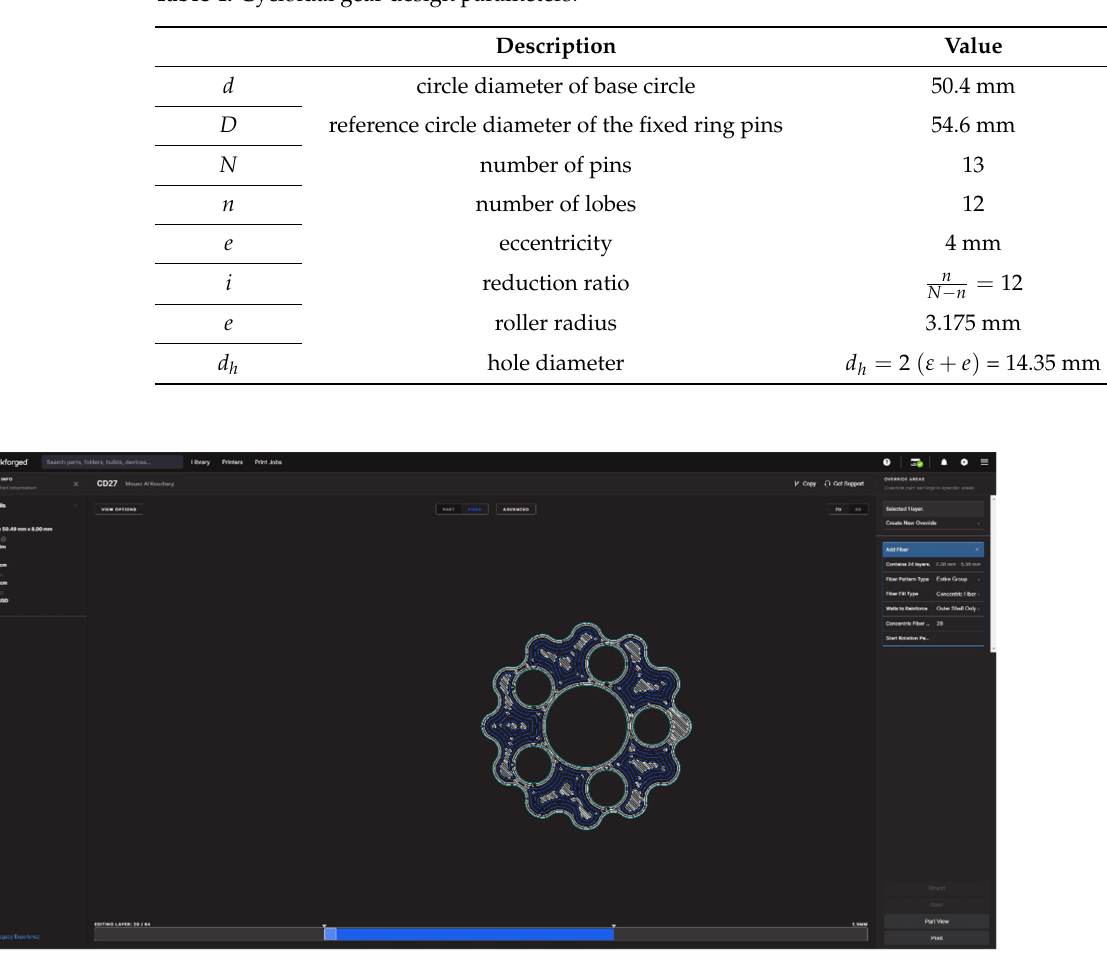
Figure 3. Initial assembly of the cycloidal gear drive for testing and load evaluation. Table 4. Cycloidal gear design parameters.